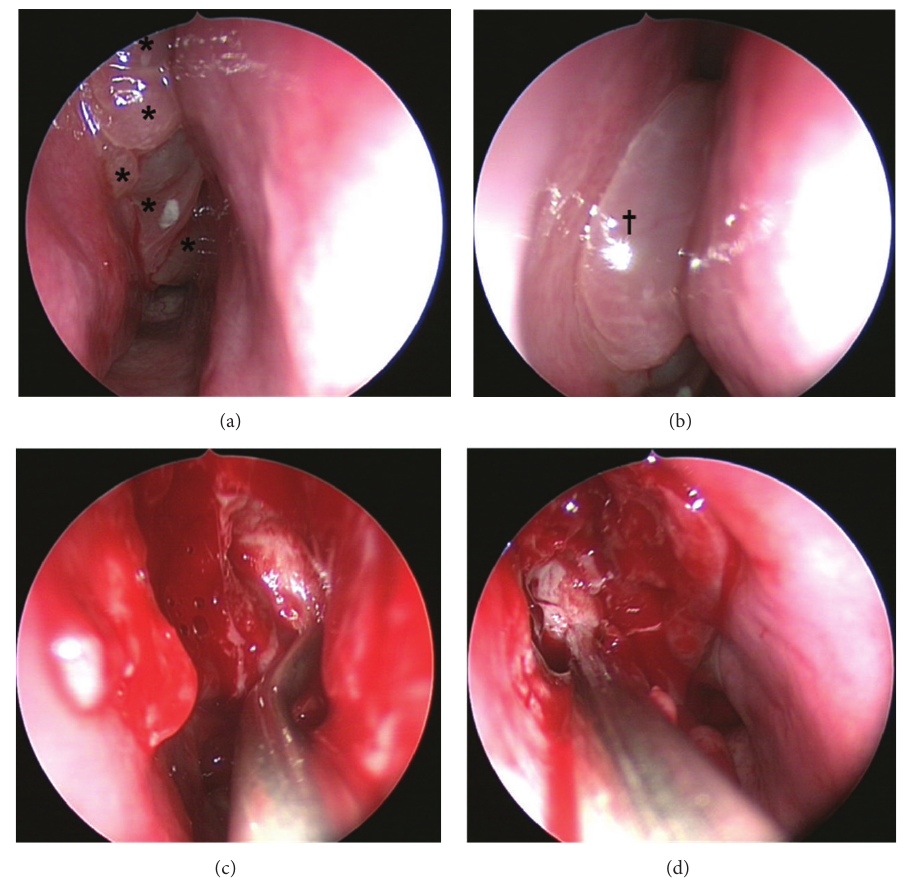
Figure 4: (a) and (b) right and left nasal sides prior to sinonasal surgery with a series of apical polyps ( ∗ ) on the right (a) and a big floating polyp ( † ) on the left nasal side, besides the middle turbinate. (c) and (d) Suction tube inside the opened left (c) and right (d) maxillary sinus.